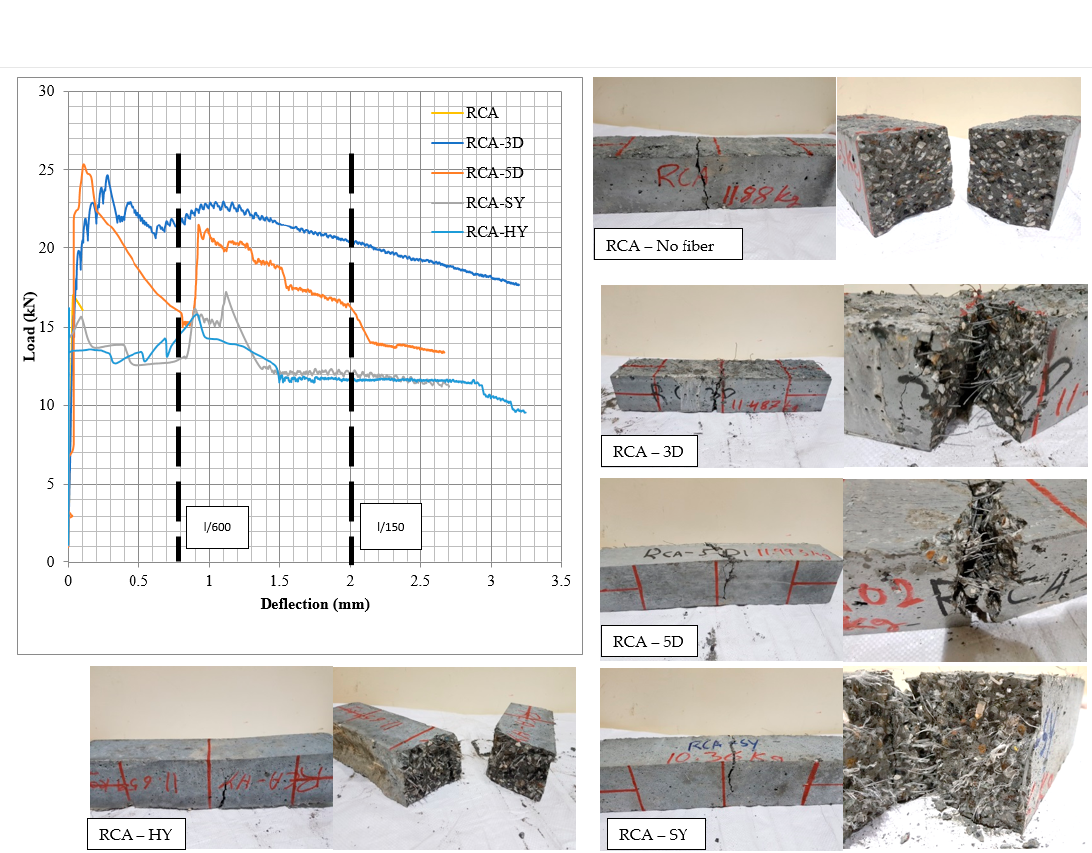
Table 9. Summary of the flexural strength results.